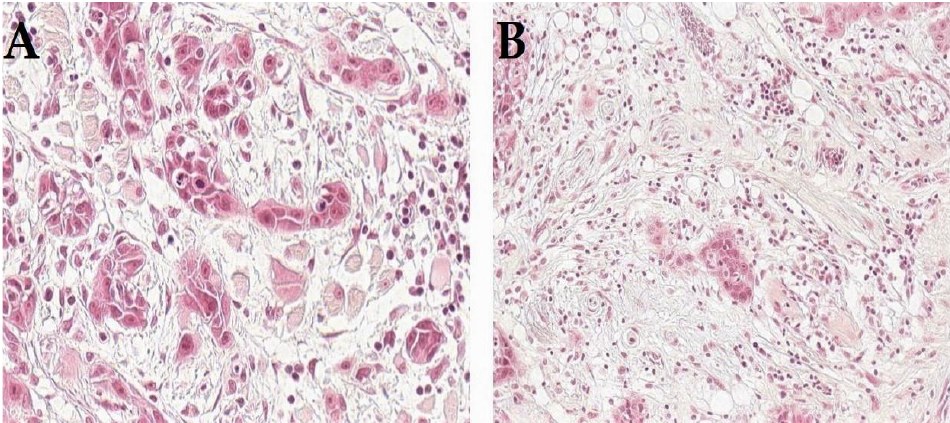
Figure 1. Histologic appearance of HNSCC with adverse prognostic features such as tumor budding ( A ) or high amount of stroma ( B ).